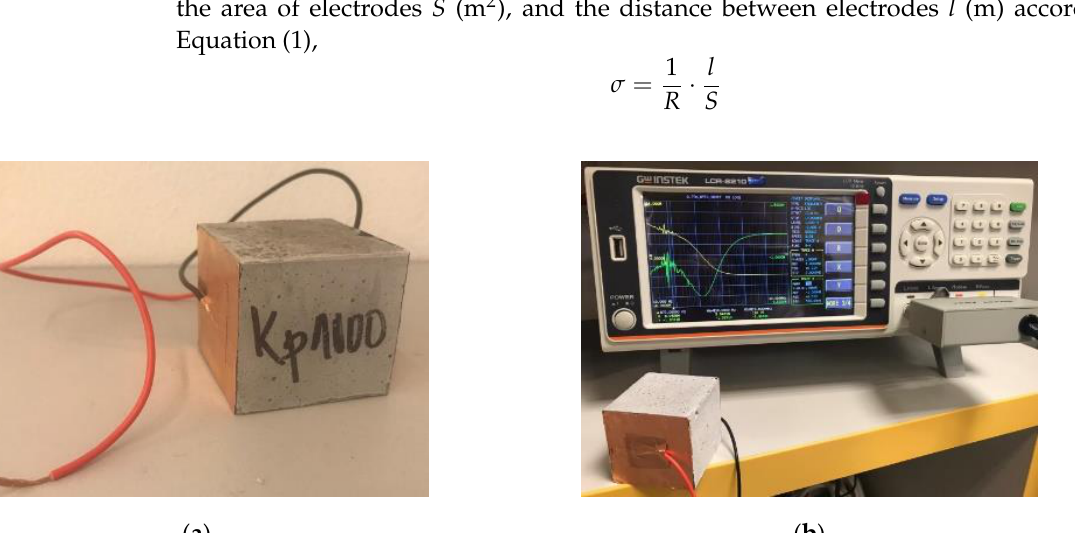
Figure 5. ( a ) Sample attached by electrodes; ( b ) LCR bridge for measurements of AC electrical properties.